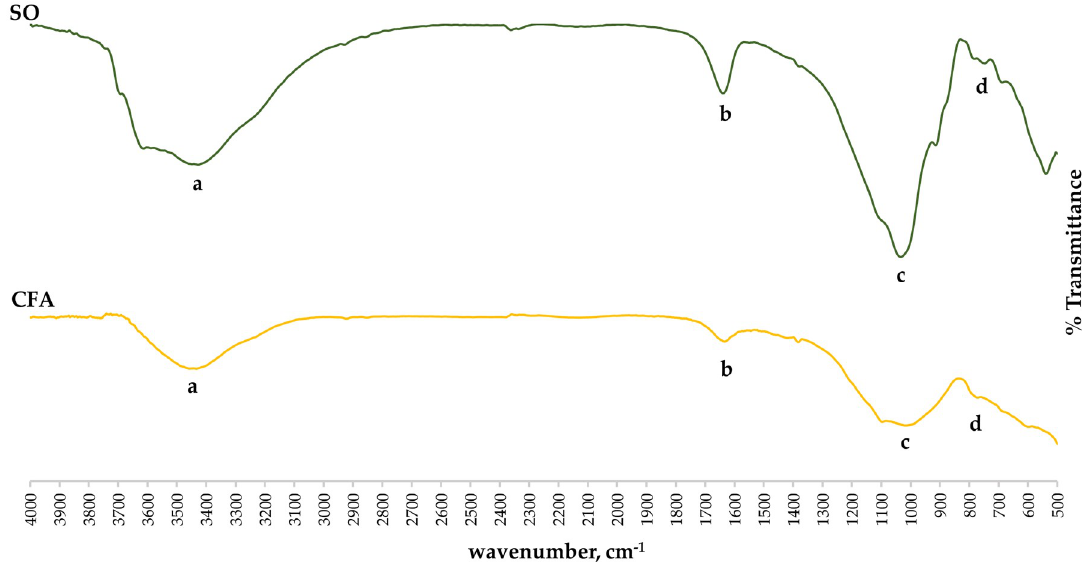
Figure 3 . FTIR spectrum of soil (SO) and coal fly ash (CFA) ( a : O–H stretching vibration; b : O–H antisymmetric stretching; c : Si–O–T antisymmetric stretching (T is either Si or Al) and; d : Si–OT bending vibration).